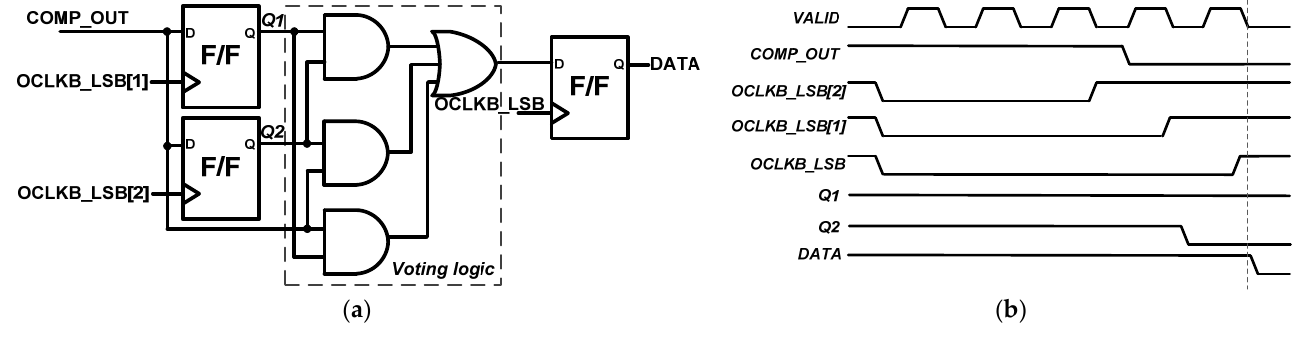
Figure 6. Voting logic: ( a ) block diagram; ( b ) timing diagram .